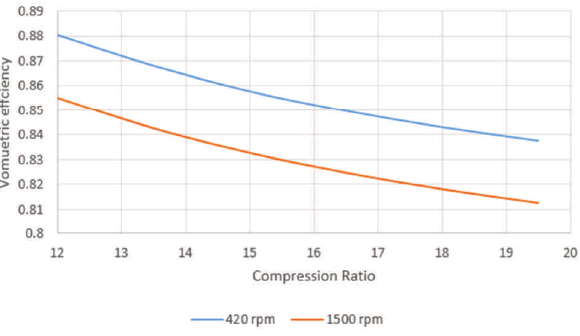
Fig. 6e. Graph of volumetric efficiency against compression